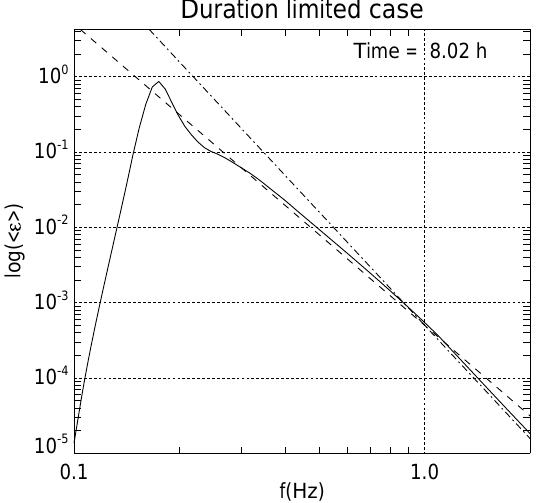
Figure 7. Decimal logarithm of the angle averaged spectrum as the function of the decimal logarithm of the frequency for the wind speed U = 10ms − 1 duration limited case – solid line. Spectrum ∼ f − 4 – dashed line; spectrum ∼ f − 5 – dash-dotted line.